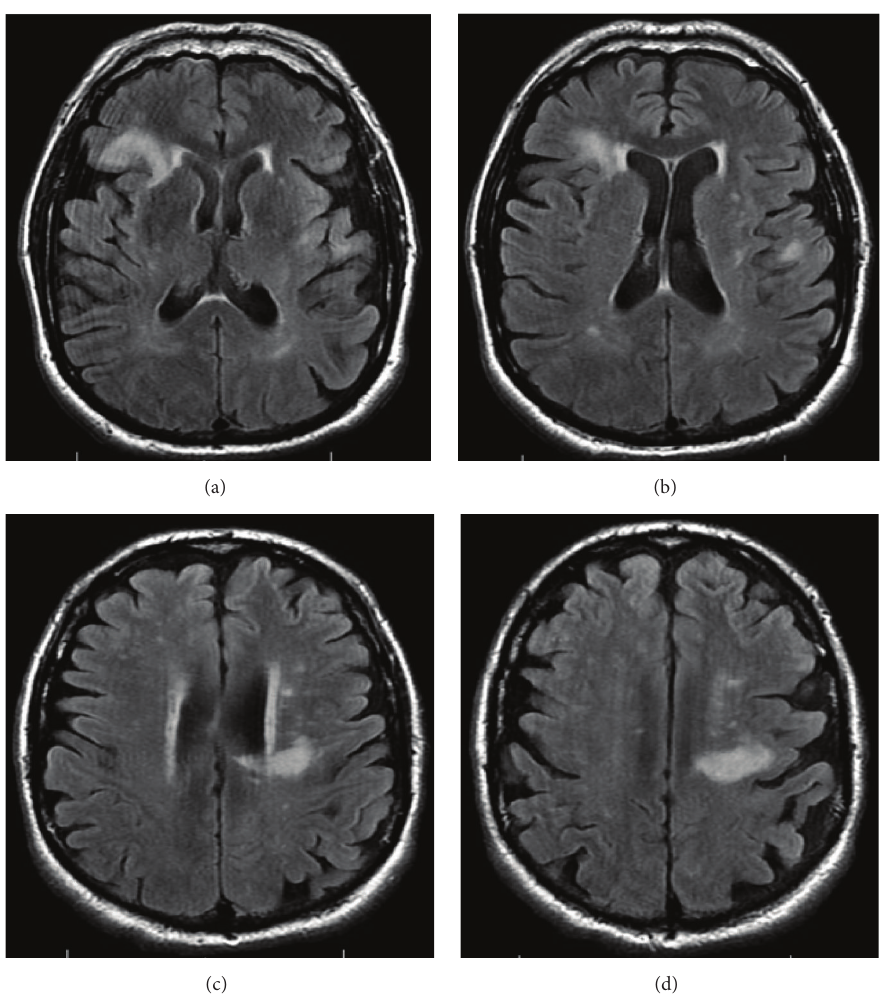
Figure 1: Axial images of MRI of the brain showing multiple confluent foci of T2-weighted FLAIR hyperintensity involving the inferior right and left frontal lobes, as well as periventricular regions (a-b). Hyperintensities are also seen in the left corona radiata (c-d). These areas are representative CNS demyelination. Several foci had restricted diffusion. There was no flow-limiting stenosis, occlusion, or aneurysm in intracranial and extracranial circulations. Images progress superiorly to inferiorly from (a) through